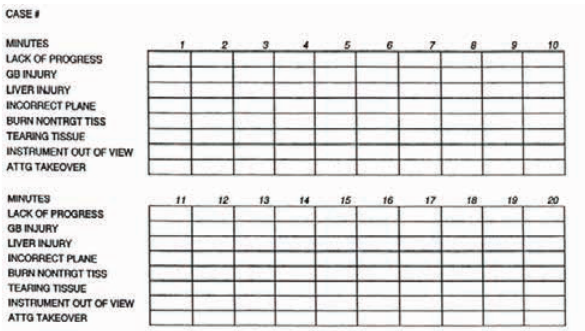
Table 5: Errors correlated to steps in video laparoscopic cholecy-